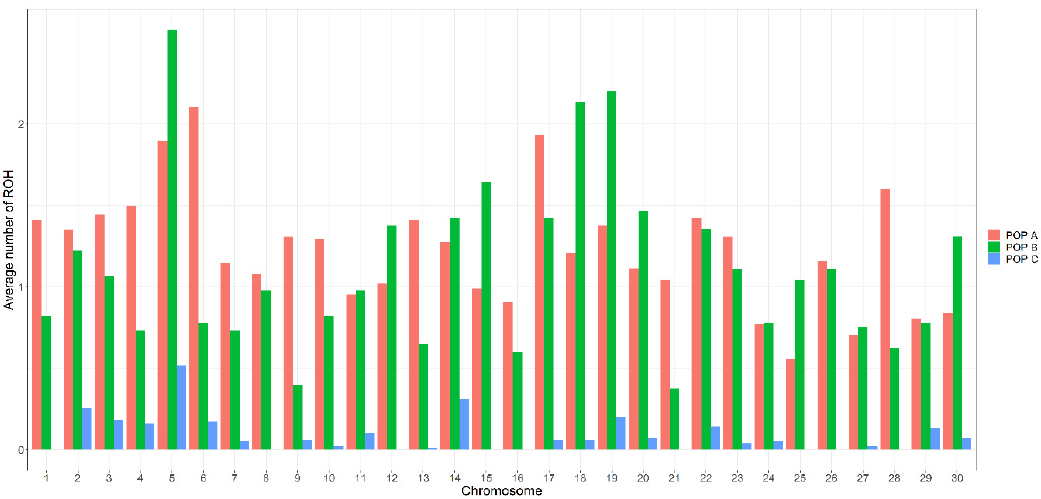
Figure 2. Distribution of the average number of ROH per individual for each chromosome in three coho salmon populations.